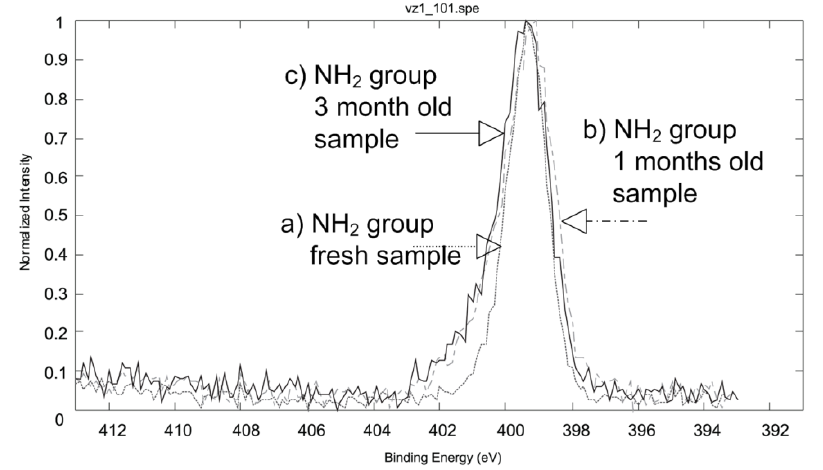
Figure 11. The result of XPS analysis of the APS modified SiO group of a freshly prepared sample; ( b ) XPS of a –NH ( c ) XPS of a –NH group of three months old 2